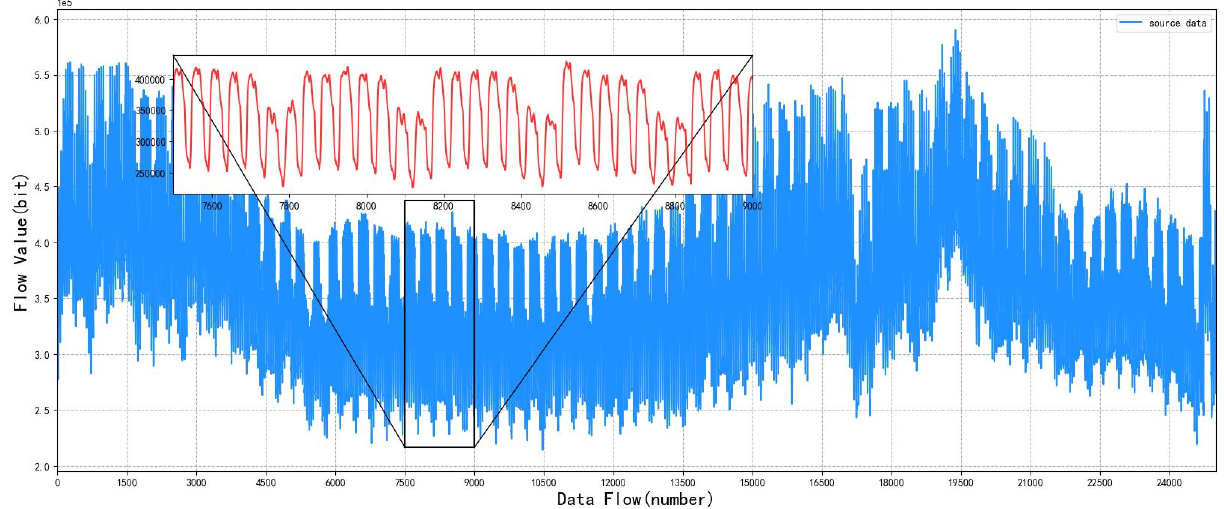
Figure 5. Original satellite network traffic data.